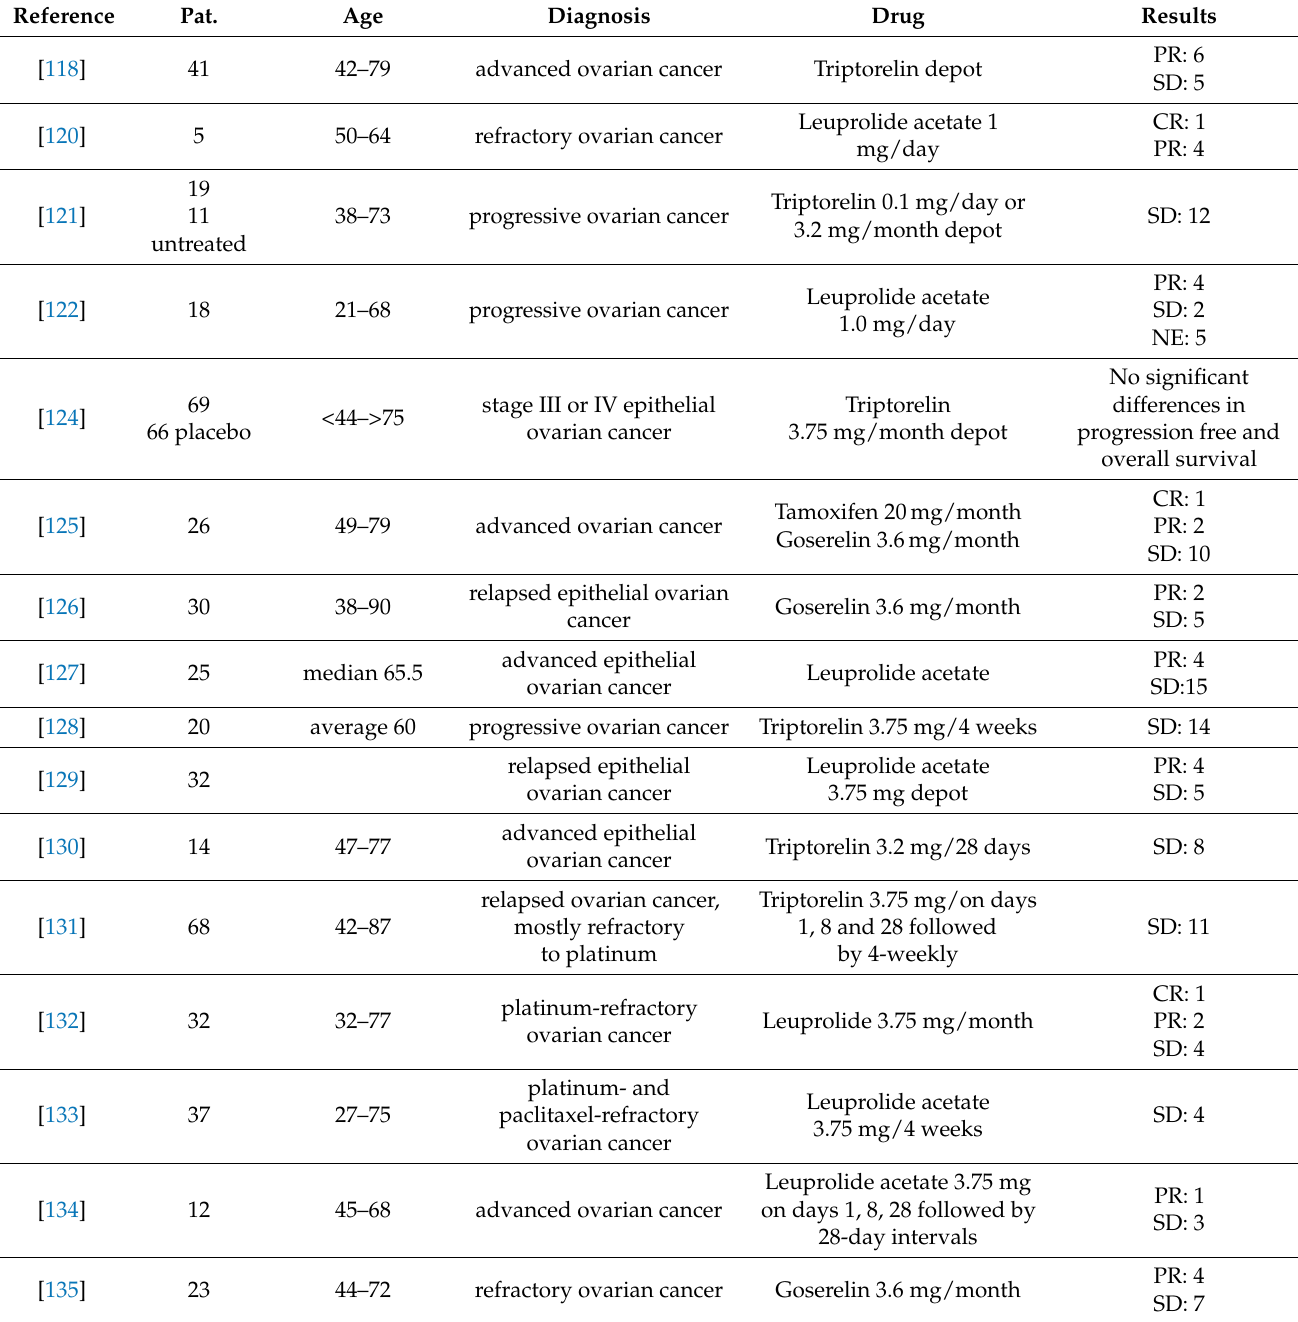
Table 1. Clinical trials—Suppression of pituitary gonadotropin secretion through GnRH-analogs as treatment for epithelial ovarian